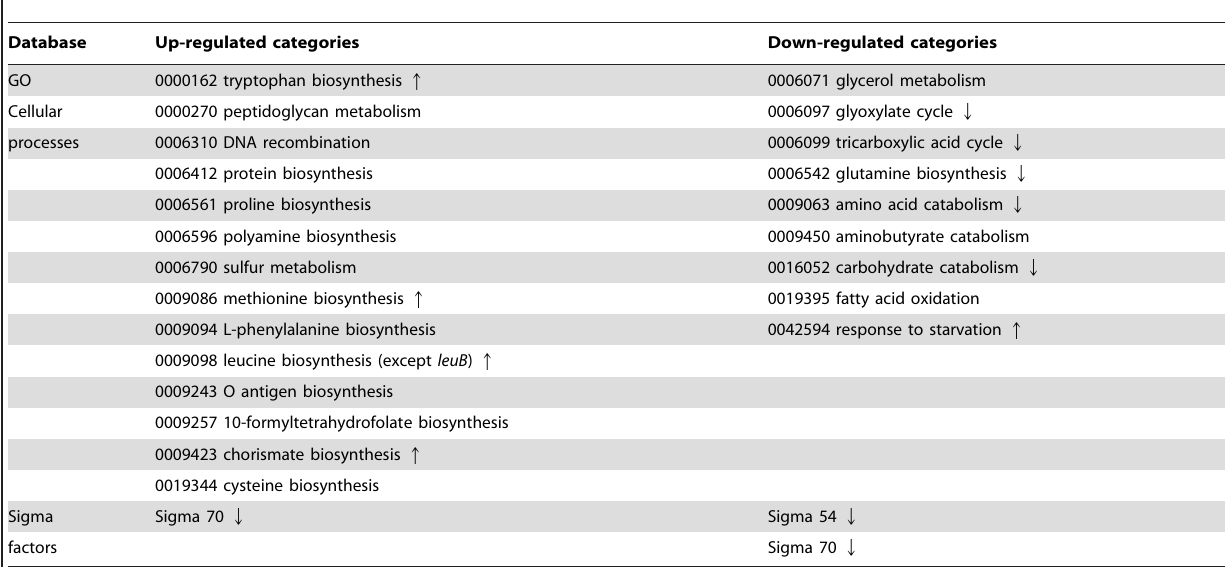
Table 1. The categories of up-regulated and down-regulated genes in L – st,co